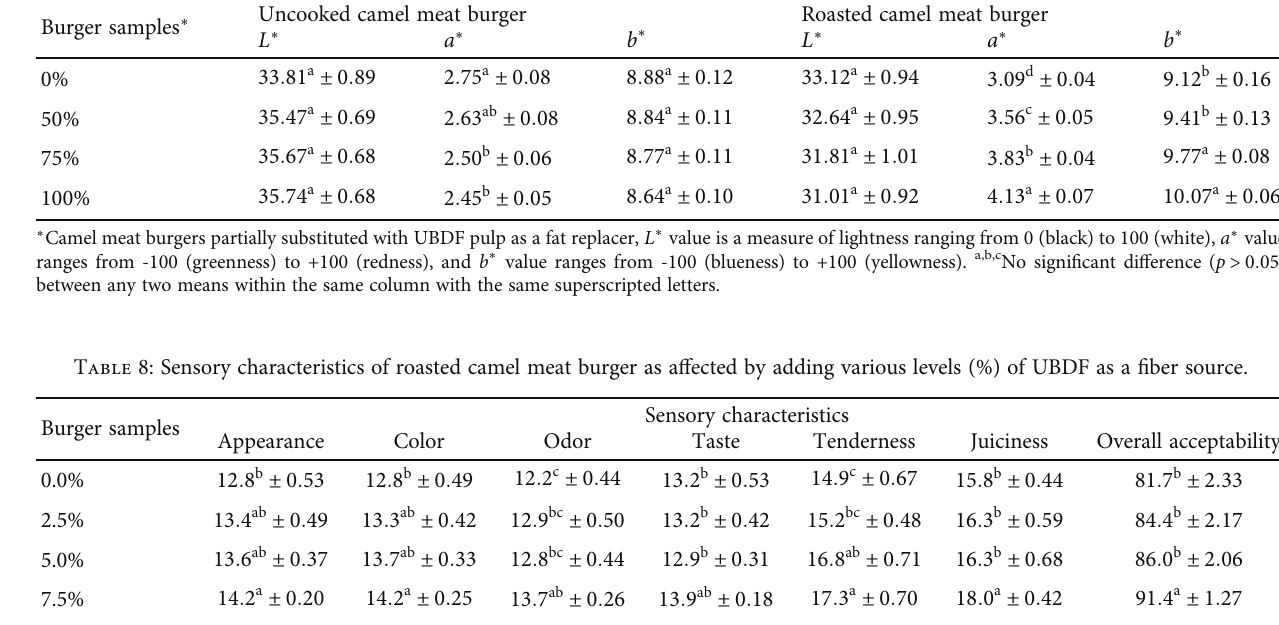
∗ Camel meat burgers partially substituted with UBDF pulp as a fi ber source, L ∗ value is a measure of lightness ranging from 0 (black) to 100 (white), a ∗ value ranges from -100 (greenness) to +100 (redness), and b ∗ value ranges from -100 (blueness) to +100 (yellowness). a,b,c No signi fi cant di ff erence ( p > 0 : 05 ) between any two means within the same column with the same superscripted letters. Table 7: Instrumental color characteristics of uncooked and roasted camel meat burger as a ff ected by replacing fat with di ff erent levels (%) of UBDF pulp. Uncooked camel meat burger Burger samples ∗